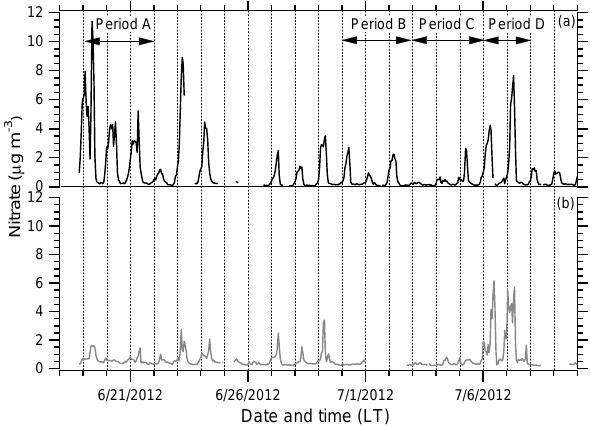
Figure 7. Time series of hourly averaged AMS nitrate observed at (a) SPC and (b) Bologna. The dashed vertical lines indicate mid- night local time (UTC + 2). Periods A, B, C, and D are also indi-